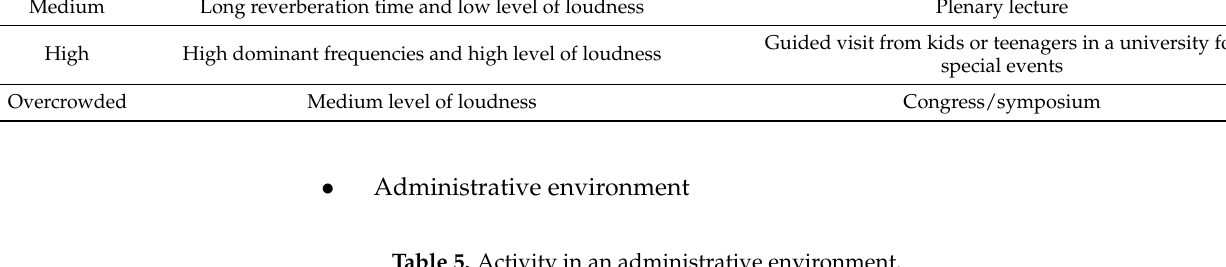
Table 5. Activity in an administrative environment.